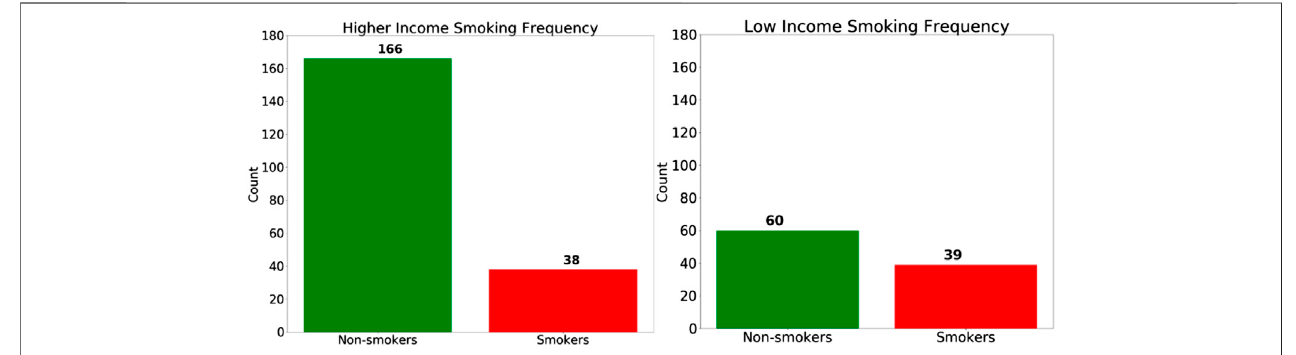
FIGURE 11 | The number of smokers and non-smokers in the each Socio-economic status (SES) group.